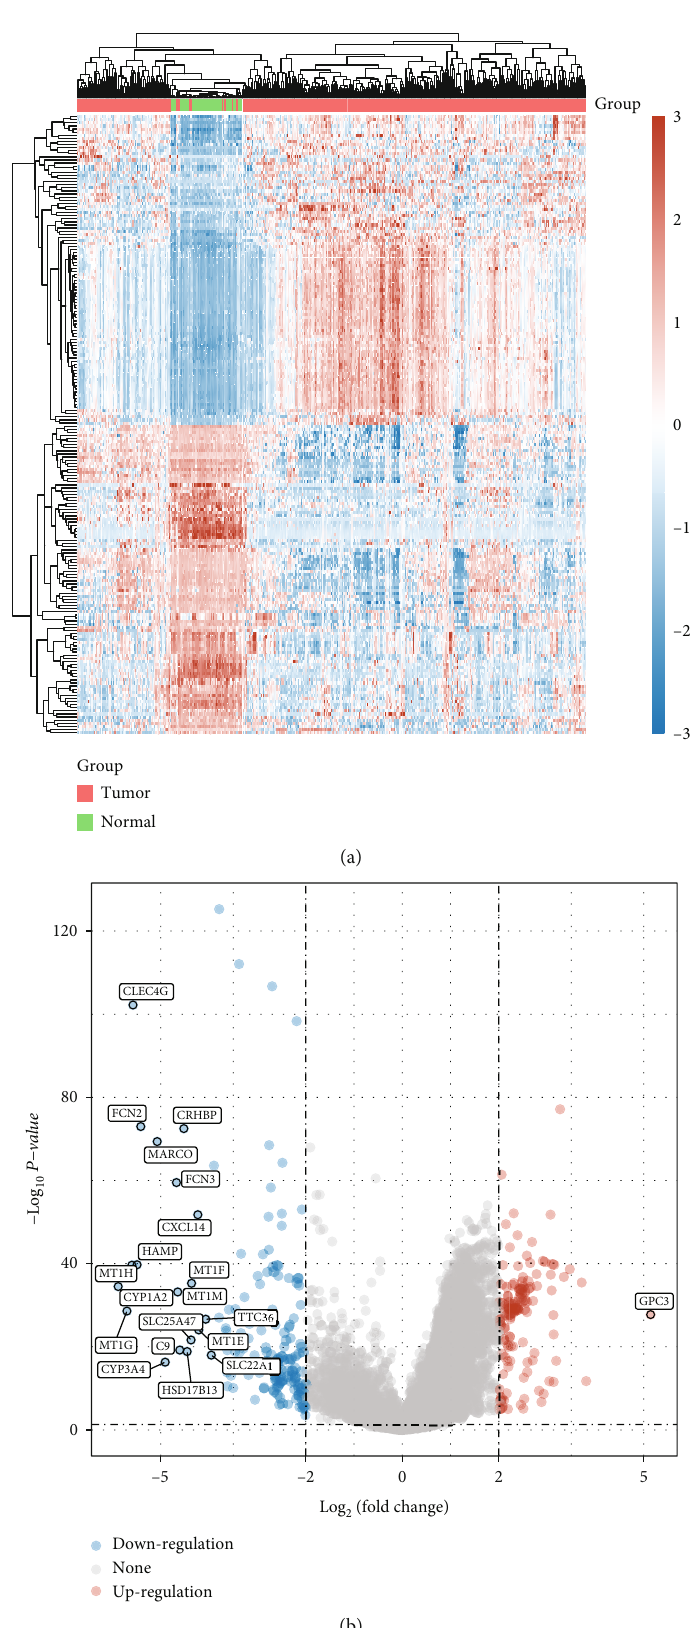
Figure 1: DEGs identi fi ed from TCGA datasets. (a) Heatmap of the all DEGs. (b) Volcano map of DEGs between HCC specimens and nontumor